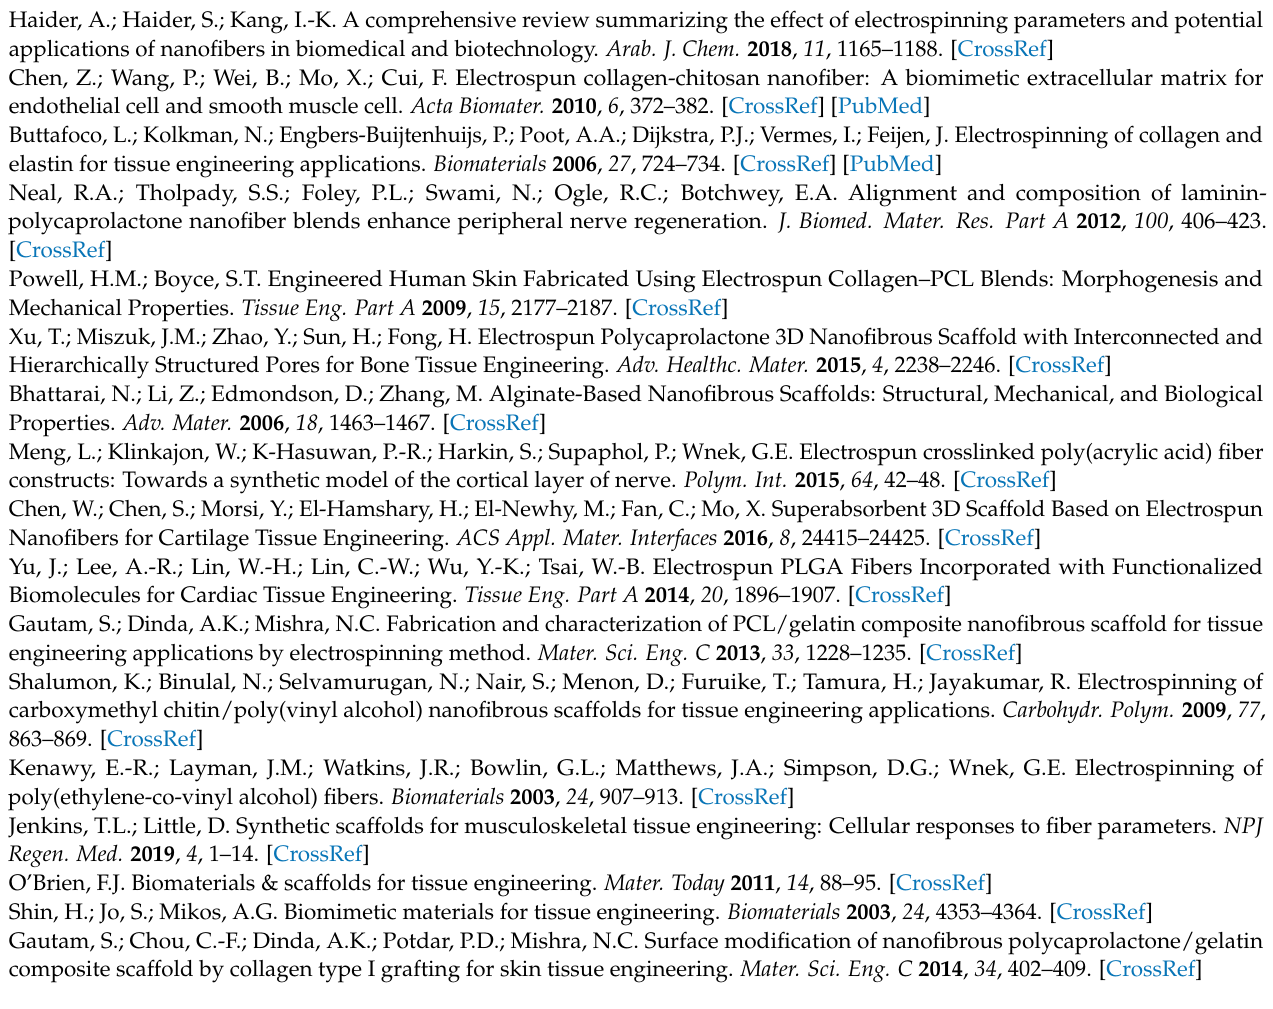
Figure S4: Short-term in vitro cell compatibility study using